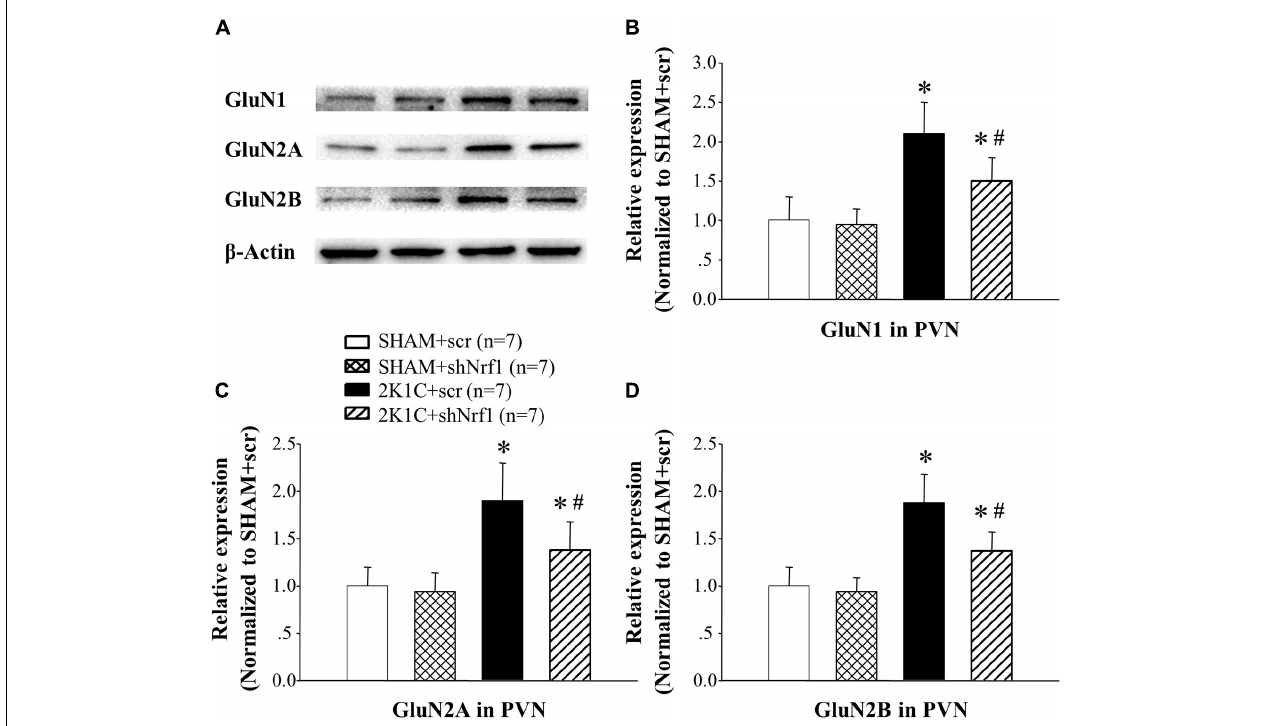
FIGURE 9 | Effects of knocking down of Nrf1 on the protein expressions of GluN1, GluN2A, and GluN2B in PVN of hypertensive rats. (A) Western blotting for the protein expressions of GluN1, GluN2A, and GluN2B in PVN in different groups; (B) group data for GluN1 protein expression in PVN; (C) group data for GluN2A protein expression in PVN; (D) group data for GluN2B protein expression in PVN. ∗ P < 0.05 vs. control animals (SHAM + scr or SHAM + shNrf1). # P < 0.05 2K1C + shNrf1 vs. 2K1C +